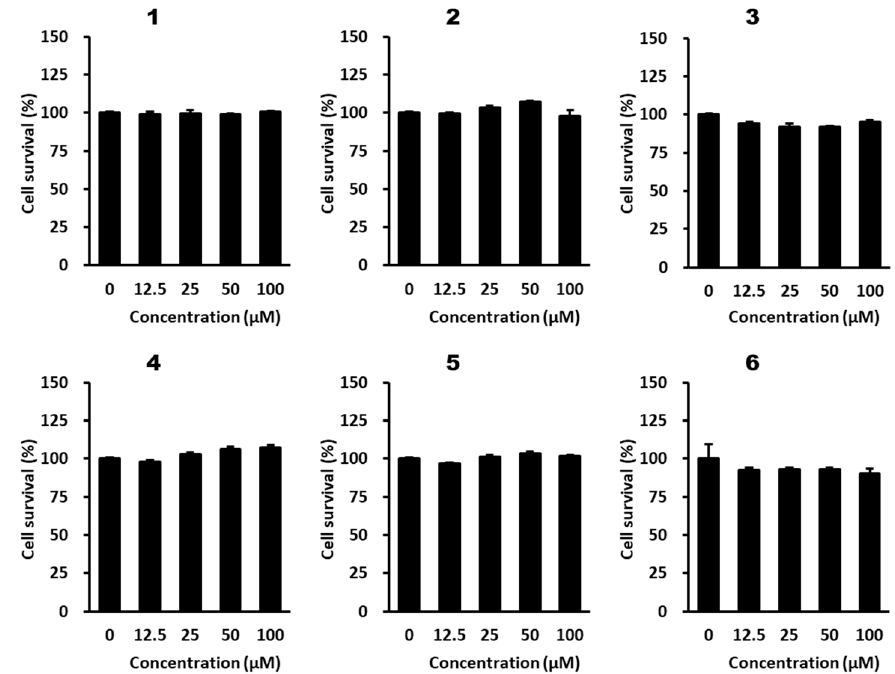
Figure 3. Effects of methoxyflavones 1 – 6 on B16F10 cell viability. B16F10 cells were seeded in 96- well cell culture plates with clear bottoms (5 × 10 3 cells/well) and were incubated for 24 h. The cells were then treated with the indicated concentrations of methoxyflavones 1– 6 for 24 h. Cell viability was evaluated using an EZ-Cytox kit. The results are presented as mean ± SEM ( n =3). 2.3. Inhibitory Effect of Methoxyflavones 1 – 6 on Melanogenesis in B16F10 Mouse Melanoma